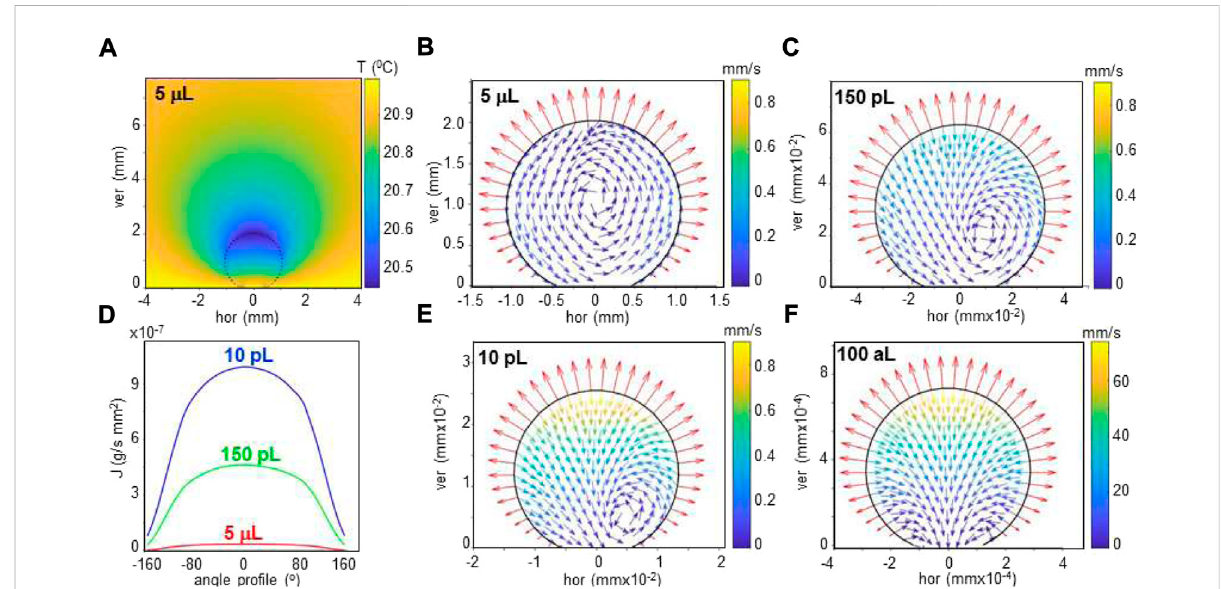
FIGURE 3 (A) Heat map of simulated temperature distribution of 5 μ L droplet on SHS (dotted circle) and its environment at about 40% humidity. The temperature of substrate and distant surrounding air are set to 21 ° C. (B) Simulated evaporation fl ux along the rim of the droplet. (C – F) : Simulation of fl ow in aqueous droplet for 5 μ L, 150 pL, 10 pL and 100 aL volumes. A recirculating fl ow is revealed by fl ow vectors for the 5 μ L droplet. For smaller droplets,theradial fl owincreasesandtherecirculating fl owcenterispushedtothecontactarea.Theevaporation fl uxvectorsarenormaltothe rim. A/B/C adapted from: (Marinaro et al., 2021); D/E: (G) M.,